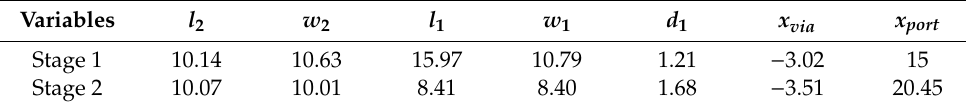
Table 3. Best designs obtained in Stage 1 and Stage 2 (all in mm ).